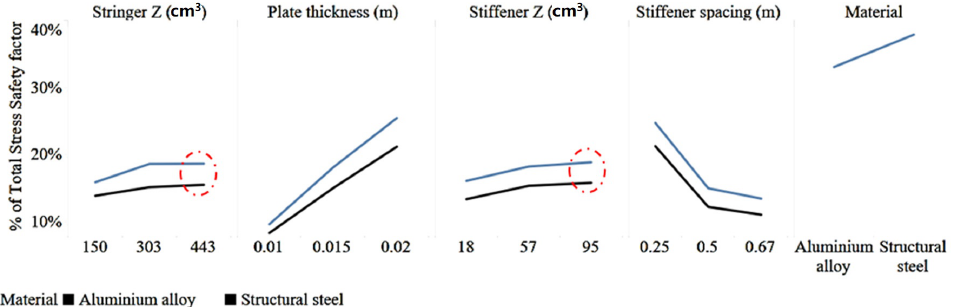
Figure 11. Parametric trend of significant parameters for metal grillage.